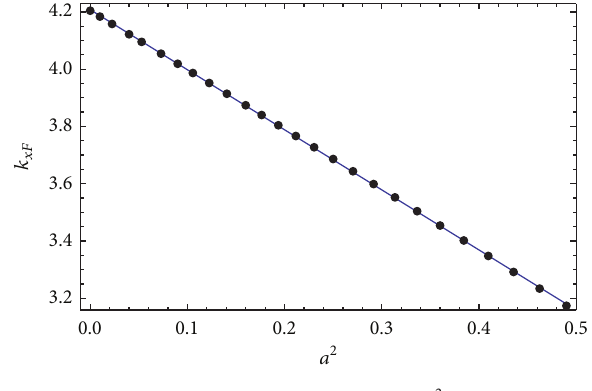
Figure 3: The plot of 𝑘 𝑥𝐹 varies as 𝑎 2 > 0